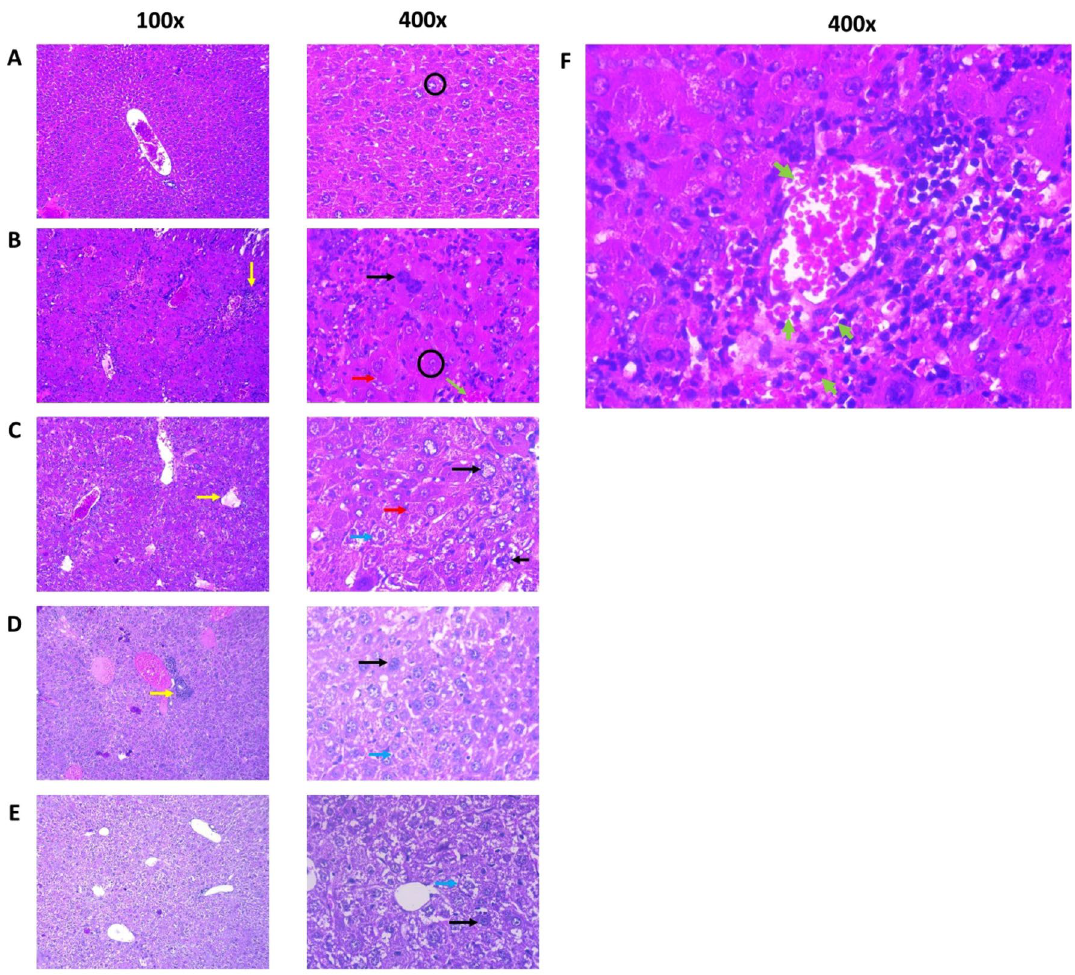
Figure 6. Histopathological picture of subjects’ livers ( A ) Normal, ( B ) Negative control induced with 25 mg NDEA /kgBW ip; ( C ) UA suspension, ( D ) Nio-UA, ( E ) Nio-UA-CS at an equivalent dose of 11 mg UA/kgBW. Picture ( F ) shows the bleeding in the liver tissue of the Negative control group. Image magnification are 100 × and 400 × with H&E staining. Black circle = hepatic plate, black arrow = hyperchromatin and enlarged cell nucleus, yellow arrow = neutrophil infiltration, blue arrow = hydropic degeneration, red arrow = cytoplasmic eosinophilic granules, green arrow =